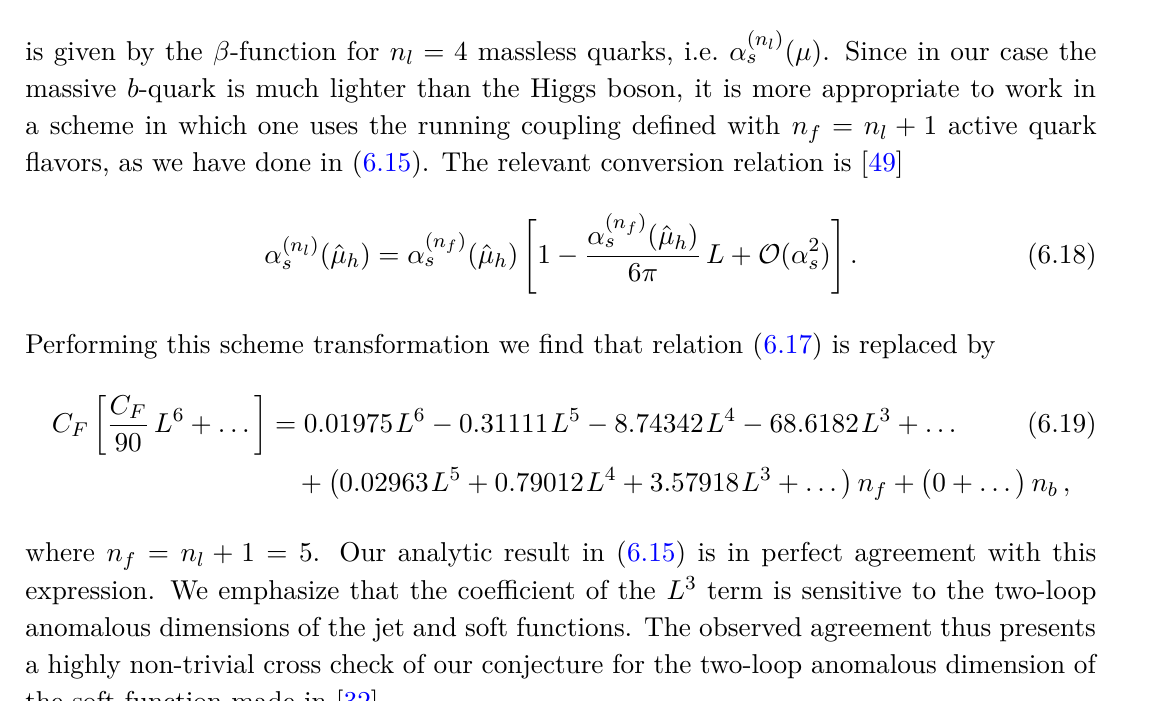
Figure 7 . Examples of three-loop Feynman diagrams containing a second quark loop in addition to the b -quark loop connected to the Higgs